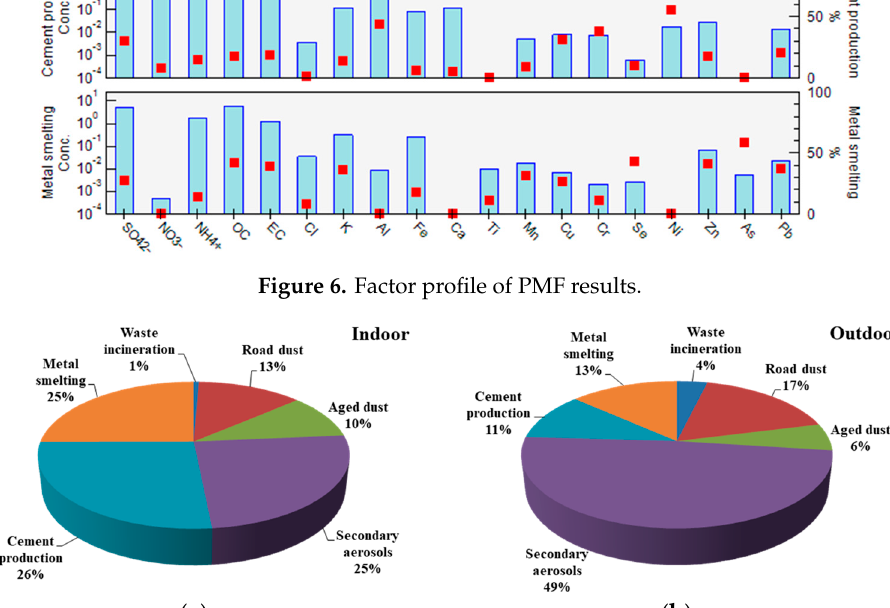
Figure 7. Contribution of six factors to indoor and outdoor PM 2.5 obtained from PMF: ( a ) indoor and ( b ) outdoor.